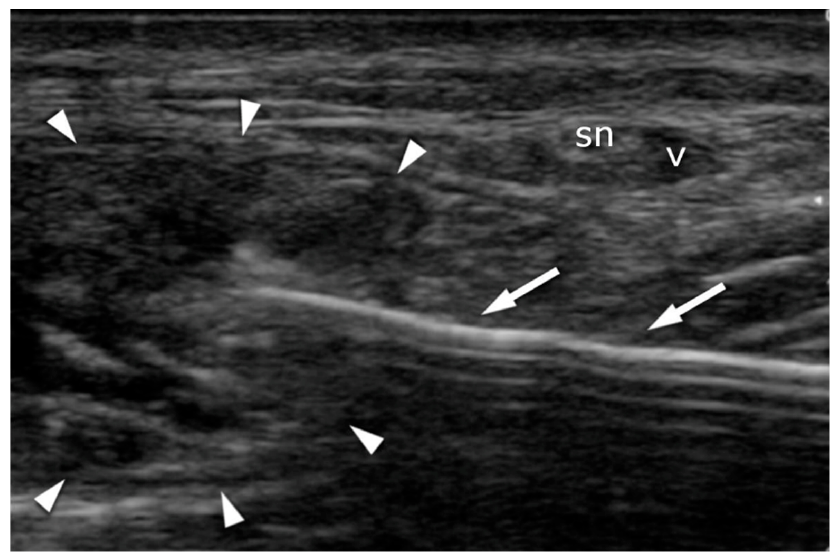
Figure 6. Achilles tendon (arrowheads) suturing: transverse plane. The needle (arrows) is introduced under US guidance in order to avoid contact with the sural nerve (sn) and the vein (v).